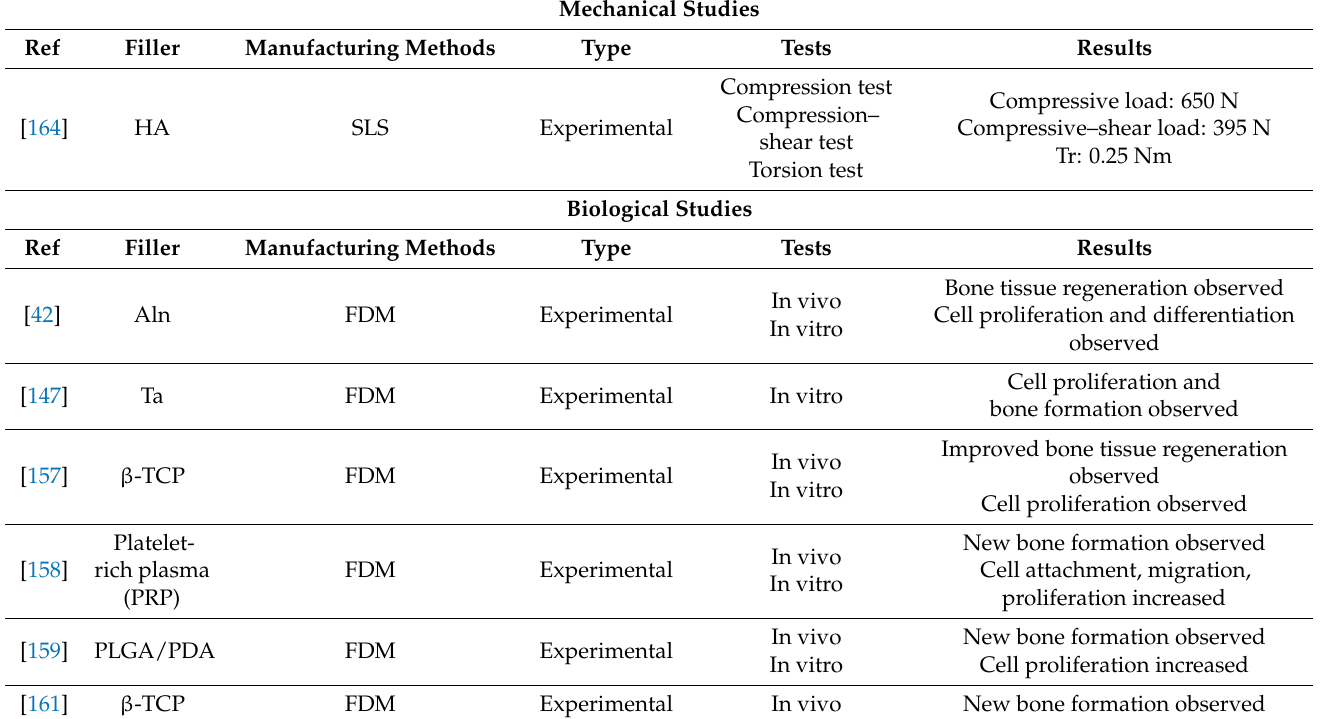
Table 7. Mechanobiological literature of PCL and its composite material; C: compressive strength, T: tensile strength, D: displacement, Y: yield strength, E: modulus of elasticity, WCA: water contact angle, B: bending strength, R: roughness, Tr: